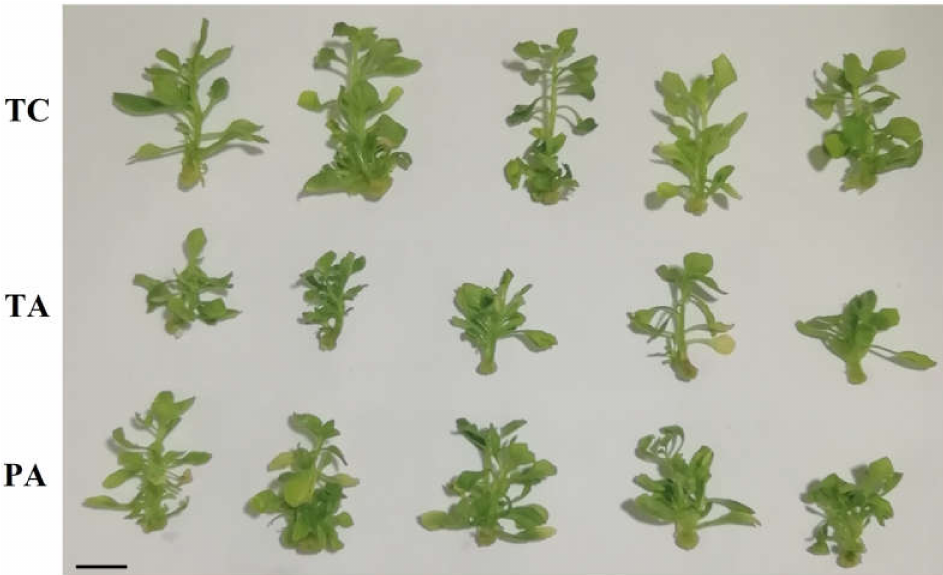
Figure 1. Representative image of control (TC), 250 mg L − 1 timentin-treated (TA) and post-antibiotic treatment (PA) tobacco in vitro shoots cultivated for 3 weeks. The scale bar size represents 10